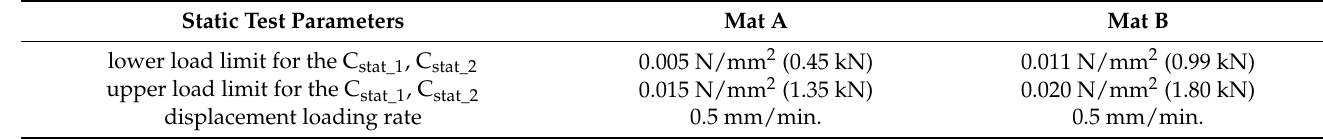
Table 1. Static load characteristics for two types of mats.